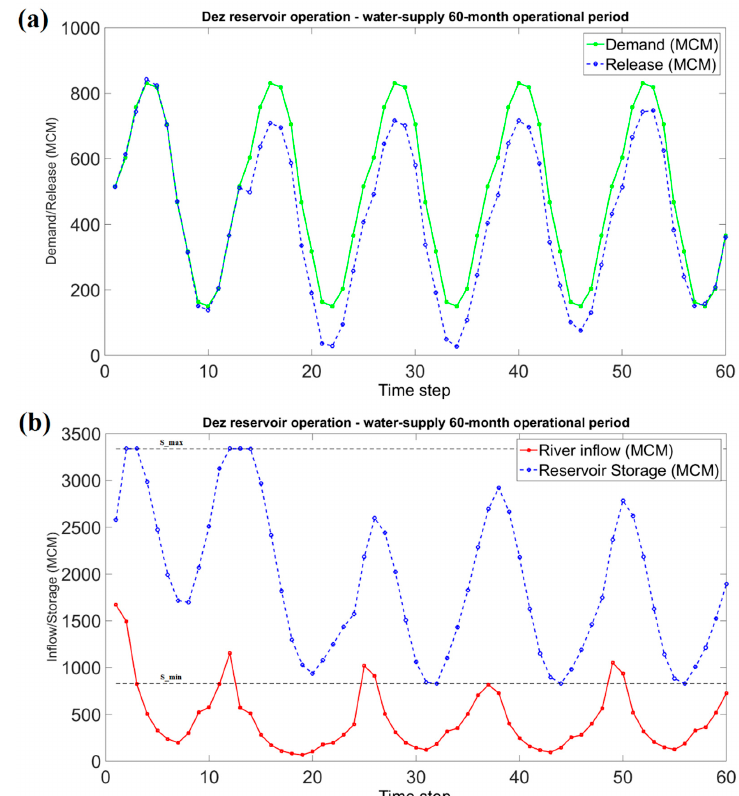
Figure 4. Best solution yielded by the CSS algorithm for 60-month water-supply operation considering evaporation losses: water demand versus release from the reservoir ( a ), and river inflow versus storage volume at each time step ( b ). As seen from the figure, the storage is confined between maximum (S_max) and minimum (S_min) allowable storage.